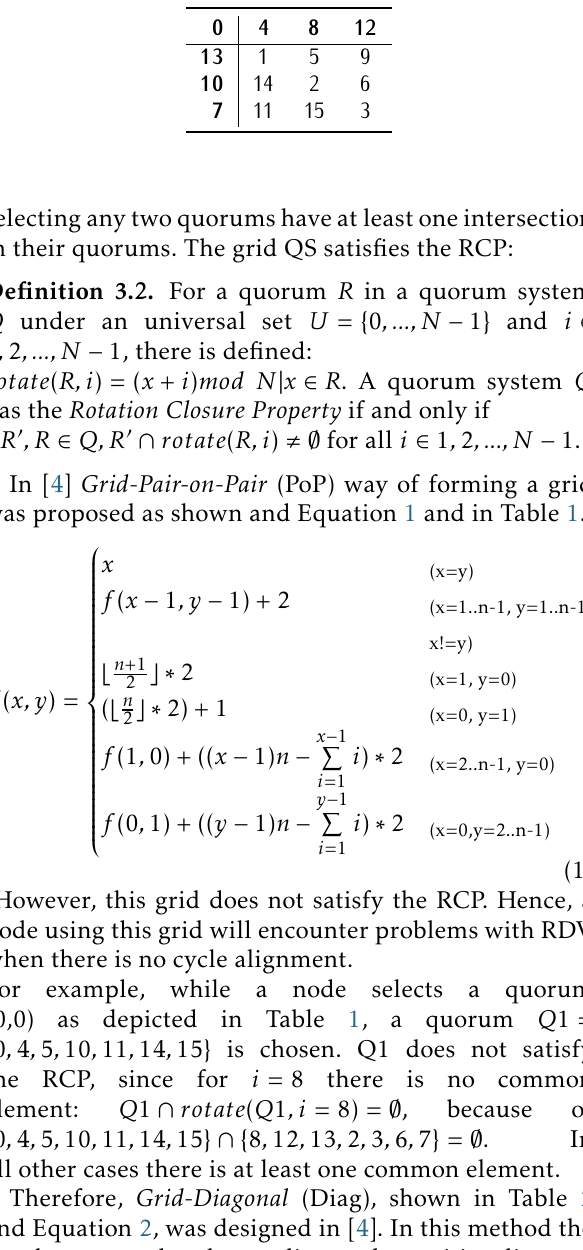
Table 2. 4x4 grid: Diagonal (Diag): quorum (0,0) in